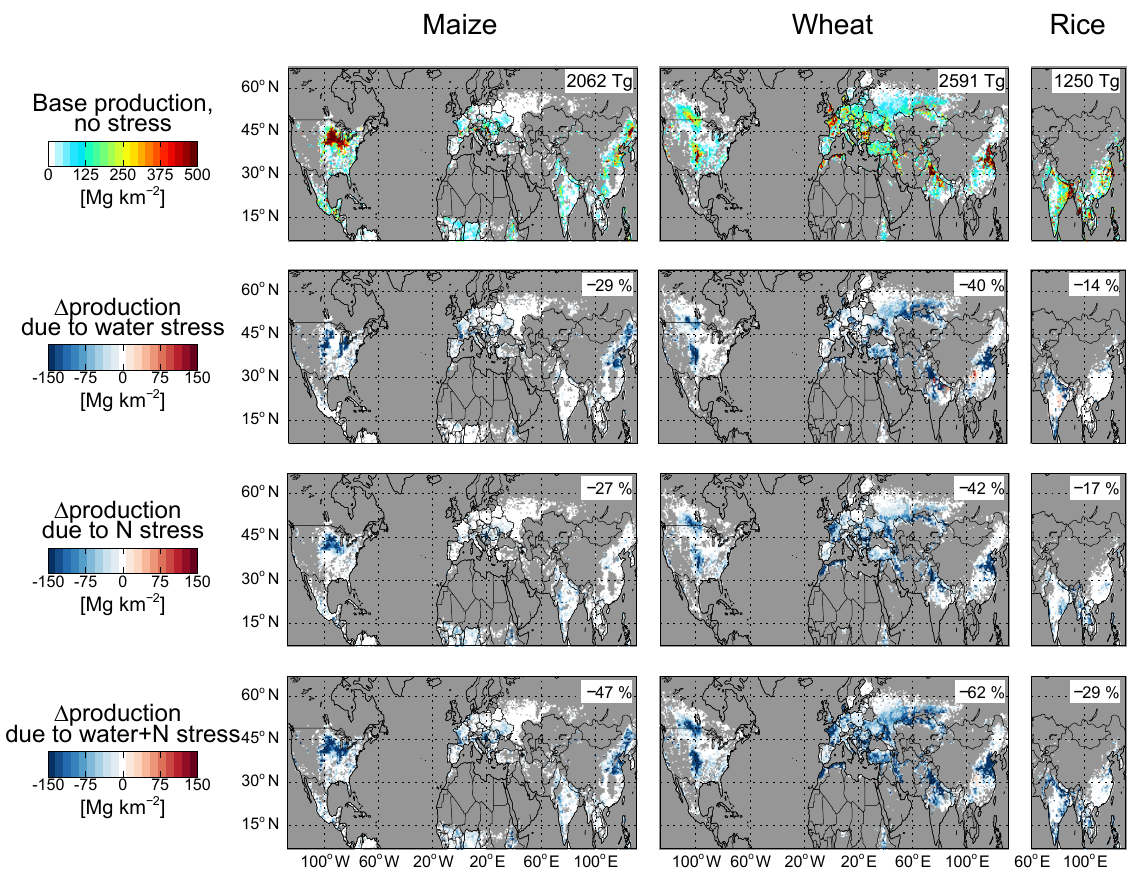
Figure 1. Top row panels: crop production from base pDSSAT scenario (GC-RT SW only, no PM) with no stress applied for growing season ending in 2010. Difference in crop production due to water stress (second row panels), nitrogen (N) stress (third row panels), and both water and N stresses (bottom row panels). For each row, maize (left column panels), wheat (middle column panels), and rice (right column panels) are shown. Filtered for GAEZ base crop production greater than 0.01Mgkm − 2 . Global production (top row panels) or relative production change (second row–bottom row panels) shown in upper right of each